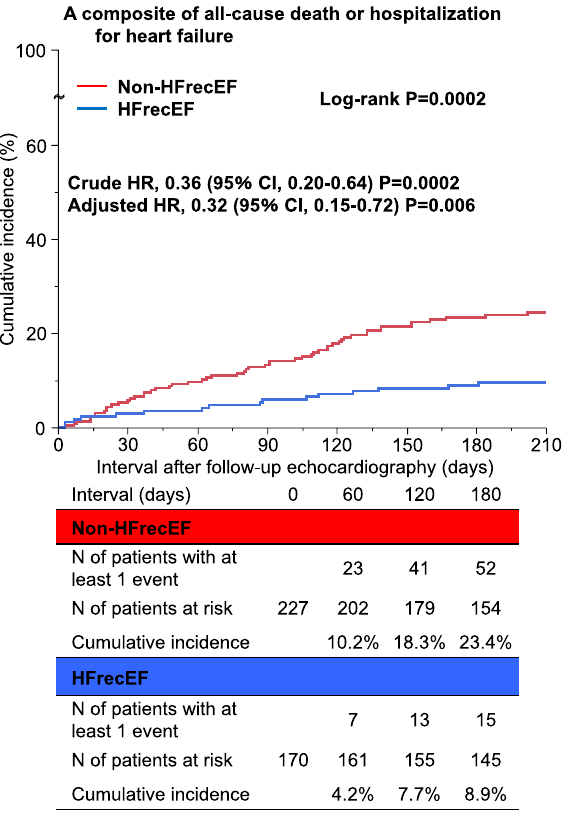
Figure 2. Kaplan Meier curves for a composite of all-cause death or hospitalization for heart failure: HFrecEF versus non-HFrecEF. Figure made utilizing JMP Pro 16.1.0, https:// www. jmp. com/ en_ us/ softw are/